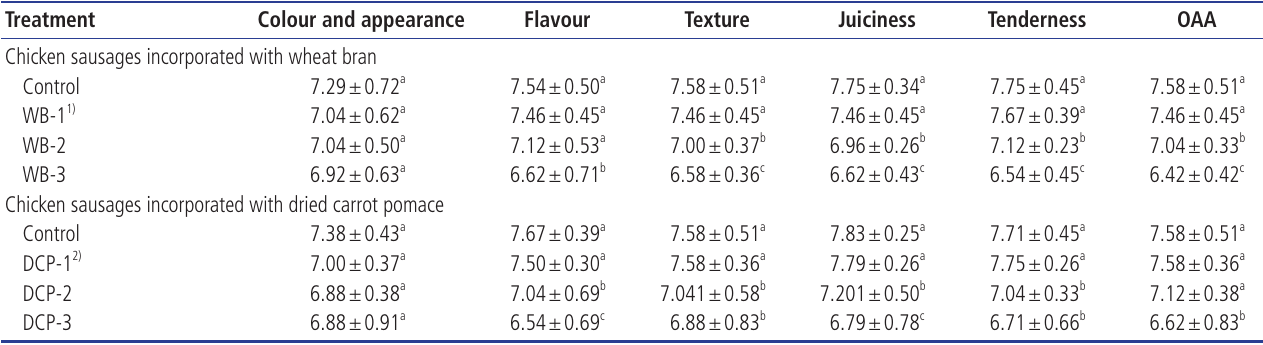
Table 1. Sensory scores of chicken sausages incorporated with different levels of wheat bran and dried carrot pomace